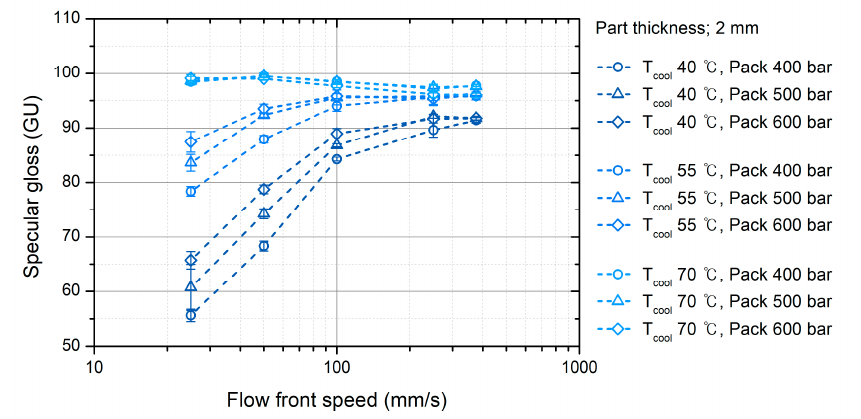
Figure 12. Surface gloss under various molding conditions.